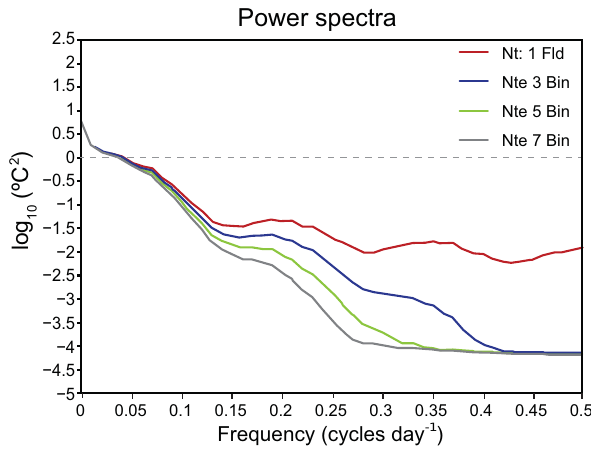
Figure A4. Spatially averaged nighttime AVHRR bias correction spectra for 2000–2005. Binomial three-point, five-point, and seven- point temporal smoothing are shown; an unsmoothed version is la- beled “Nt 1 Fld”.